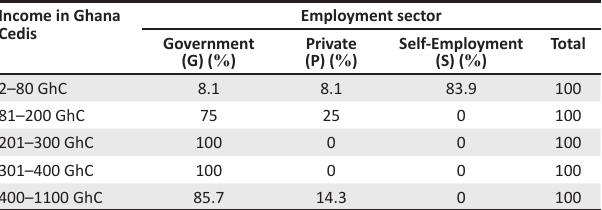
TABLE 7: Respondents monthly income by Sector ( % ) ( N = 81 G 21, P 8 and S 52) . Income in Ghana Cedis